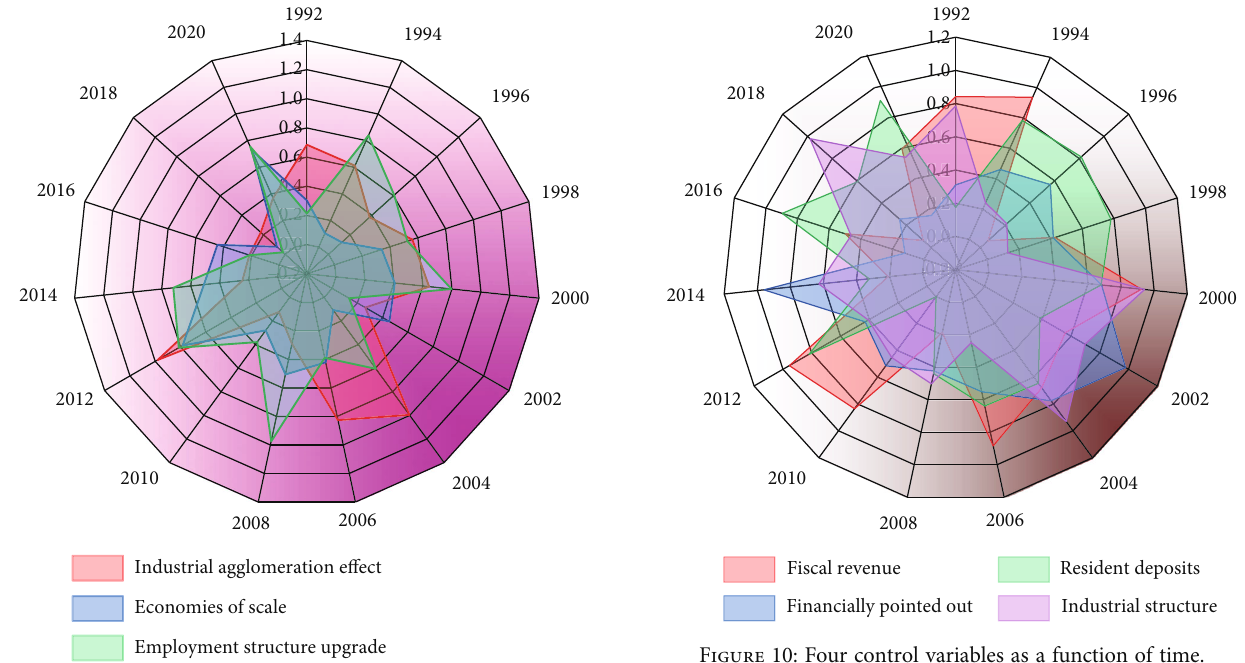
Figure 9: Trends of the three mechanisms over time.